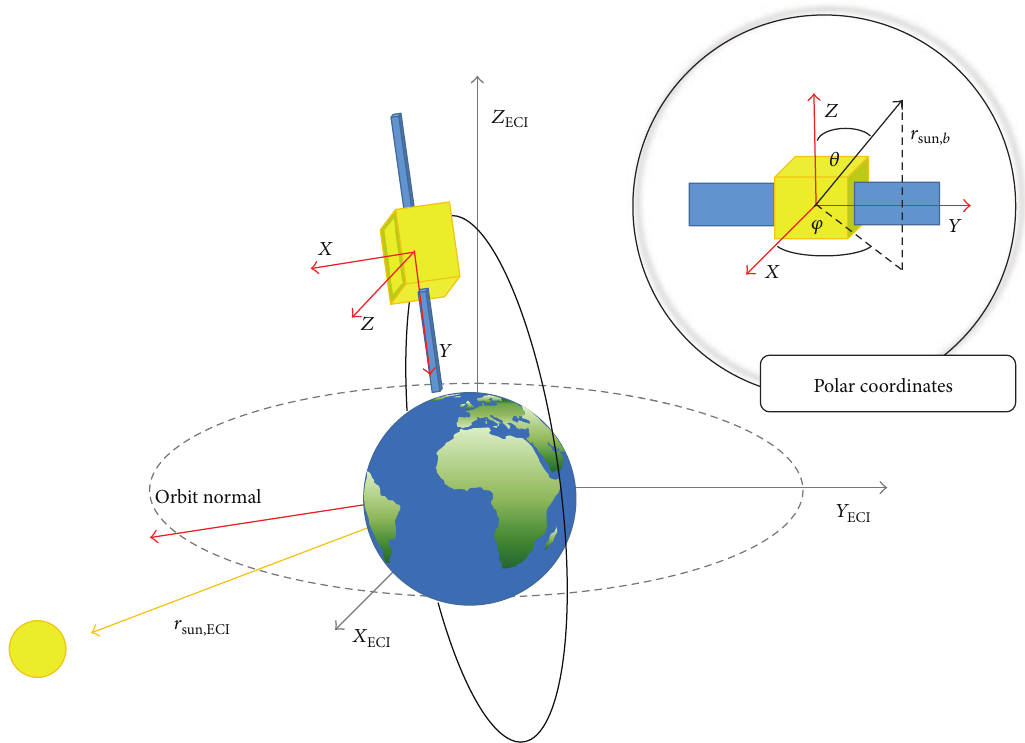
Figure 3: Illustration of MICROSCOPE orbit with respect to Earth-centred inertial coordinates (ECI). Small picture: definition of vector to the Sun in polar coordinates 𝜃 and 𝜑